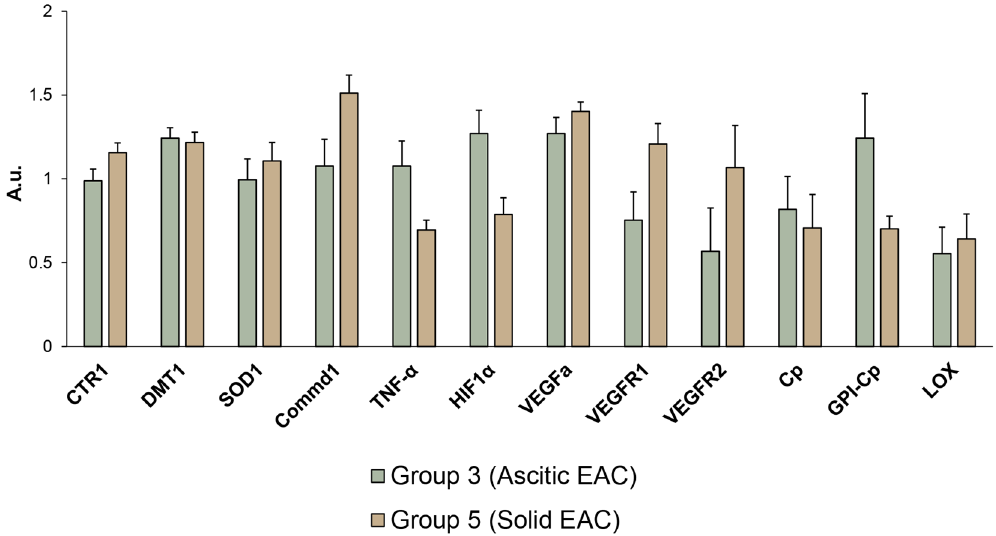
Figure 12. Expression level of the copper-related genes in ascitic EAC and solid EAC.